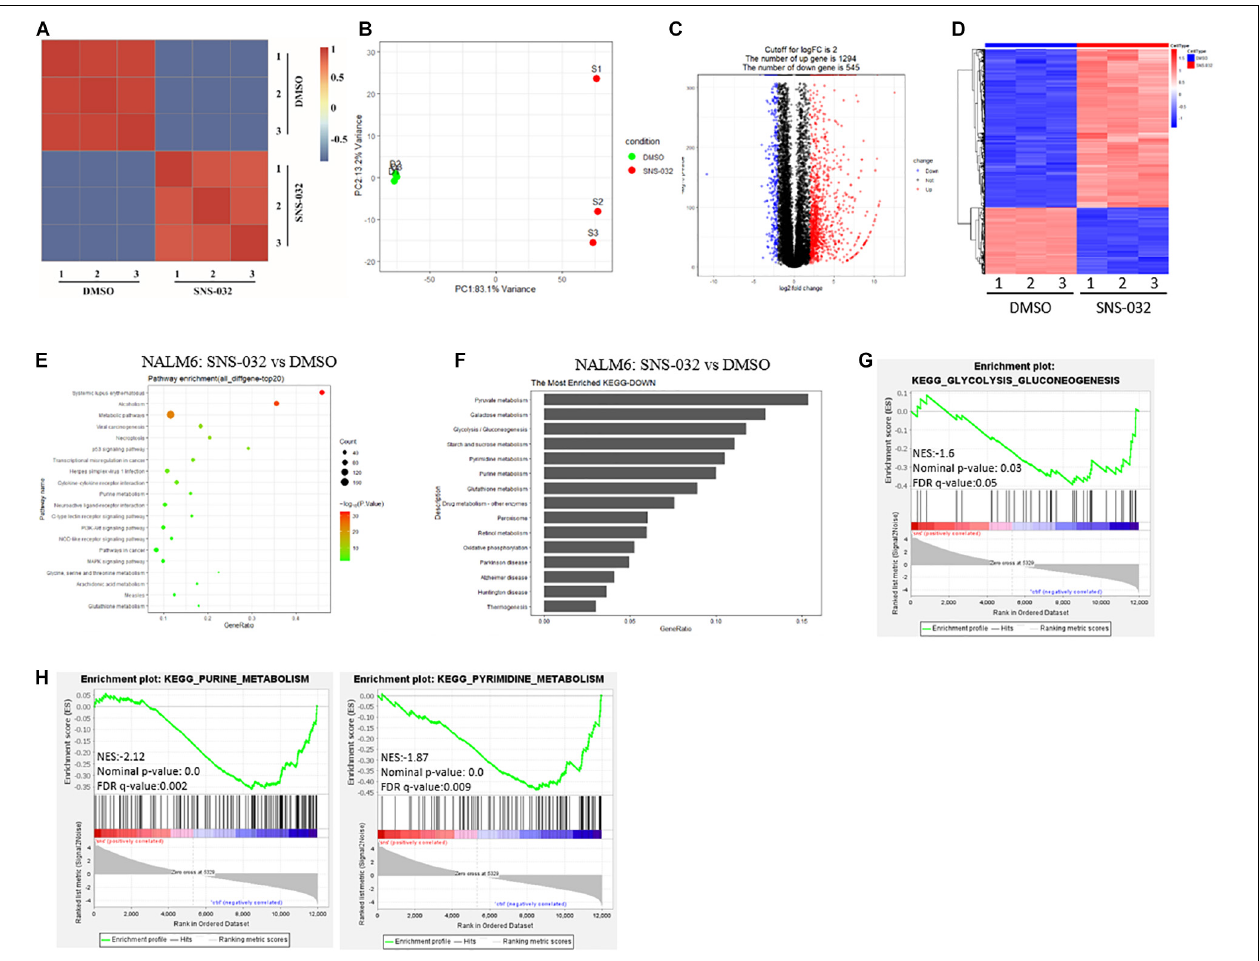
FIGURE 2 | Effect of SNS-032 treatment on the cellular metabolic pathways of B-ALL cells. (A,B) Correlation analysis and principal component analysis of the RNA-seq data from SNS-032-treated versus DMSO-treated REH cells. (C,D) Volcano plot and heatmap of differentially expressed genes by a log2-fold change ≥ 2.0 or ≤ − 2.0 (padj < 0.001) in SNS-032-treated versus DMSO-treated REH cells. (E) Pathway analysis of up- and downregulated genes (padj < 0.001) in SNS-032-treated versus DMSO-treated REH cells. (F) Pathway analysis of downregulated metabolic genes (padj < 0.001) in SNS-032-treated